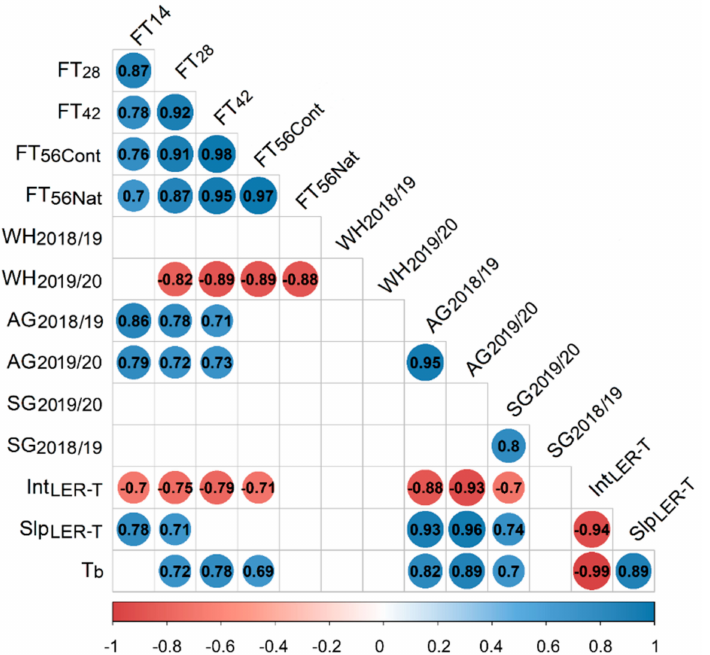
Figure 7. Spearman correlations between trait means of thirteen winter wheat cultivars, where FT 56Cont and FT 56Nat denote freezing tolerance after fifty-six days of cold acclimation in the climate chamber and under natural conditions in the semi-field, respectively; AG 2018/19 and AG 2019/20 indicate autumn growth; SG 2019/20 and SG 2018/19 denote spring growth; WH 2018/19 and WH 2019/20 are winter hardiness; Int LER-T is the intercept and Slp LER-T is the slope of the response of the leaf elongation rate (LER) to temperature as well as derived base temperature T b ; 2018/19 and 2019/20 stand for the autumn–winter season of the first and second experimental year, respectively. Positive correlations are presented in blue, while negative correlations are depicted in red